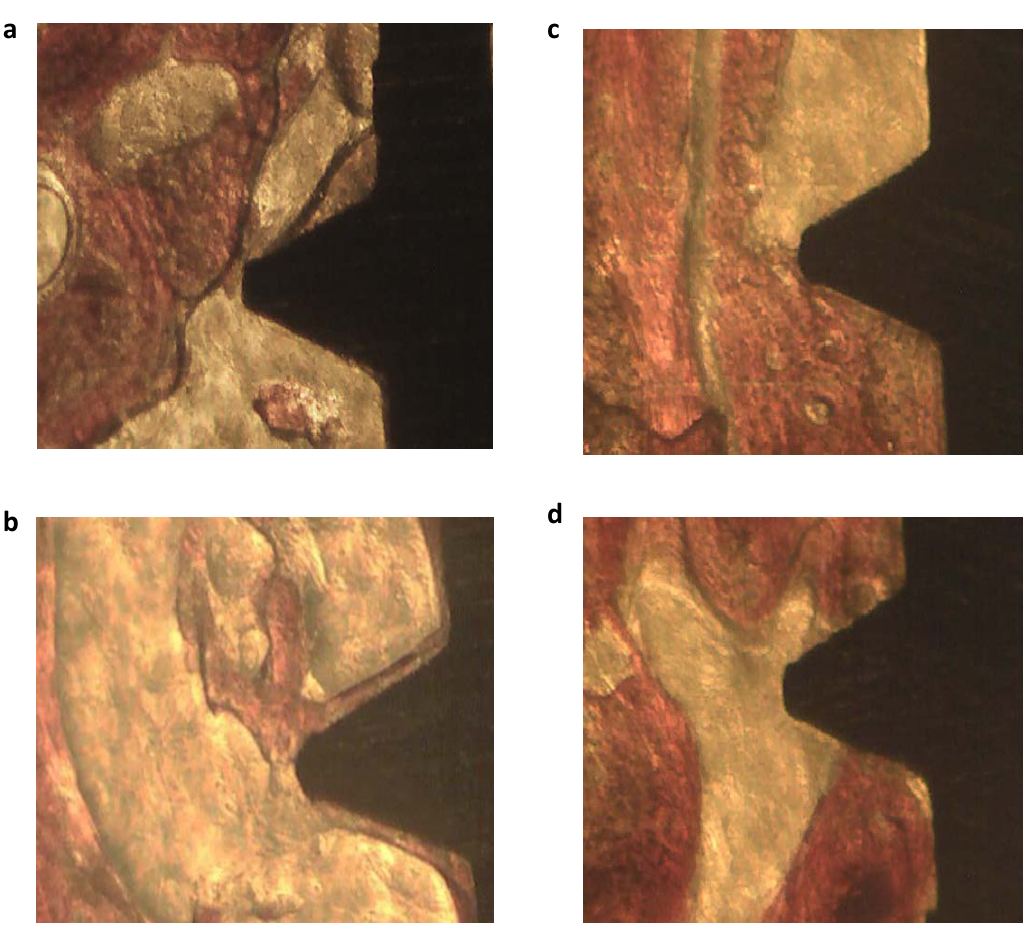
Figure 1. OM analysis of two selected coronal ( a , c ) and apical ( b , d ) ROI from two implant specimens at 200x magnifications. The apical and coronal side of the implant specimens revealed differences in their composition, and the apical side of both specimens revealed a higher presence of bone marrow areas. In contrast, coronal bone revealed a higher presence of remodeling areas (as evidenced by osteon structures). Materials 2020 , 13 , x FOR PEER REVIEW